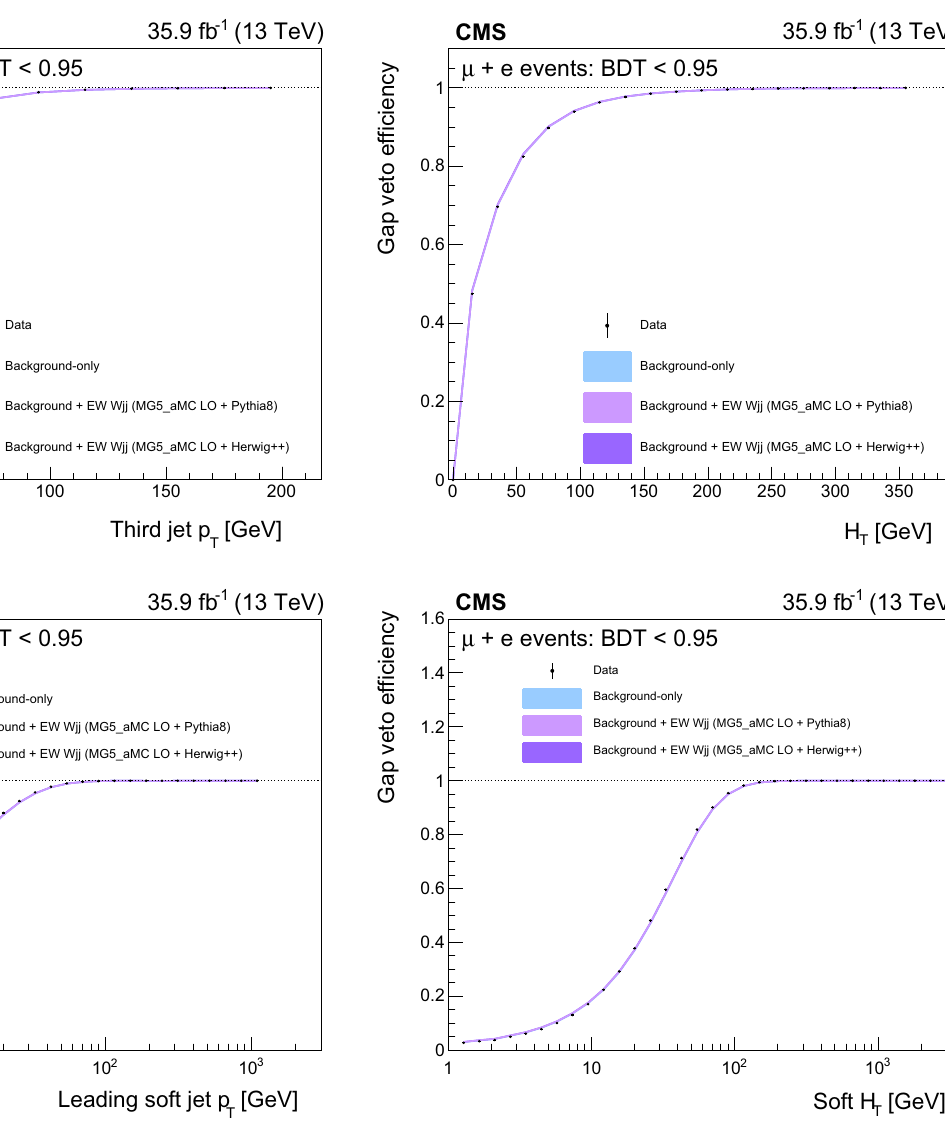
tion as well as background+signal with pythia parton showering and background+signal with herwig++ parton showering. The uncertainty bands include only the statisticaluncertainty in the prediction from sim- ulation. There is very little difference between the predictions due to the small fraction of signal in this